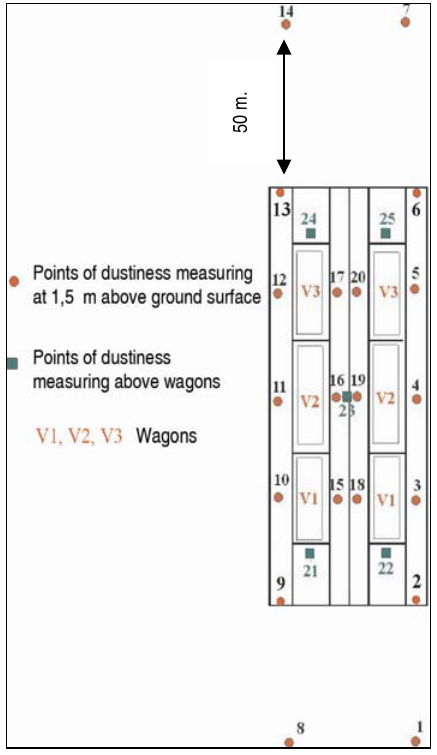
Fig 2 . Points of measuring dustiness at Terminal of Pow- dery Manure Discharge